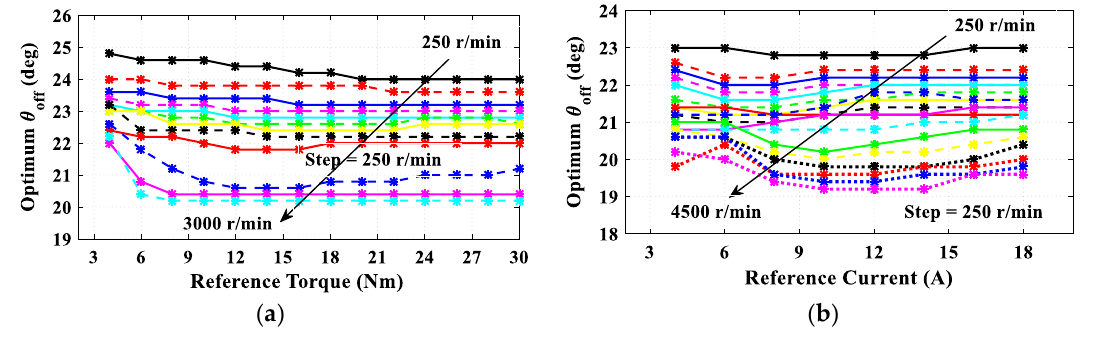
Figure 11. The optimized θ off angles: ( a ) DITC, ( b ) ATC.